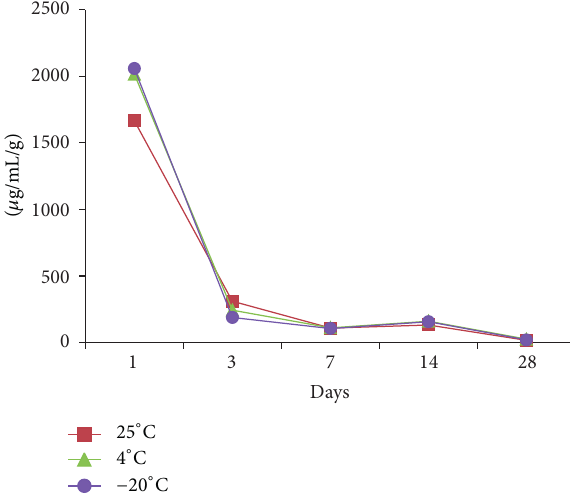
Figure2:Thereleaseofvancomycinfromsamplesstoredatdifferent temperatures for 3